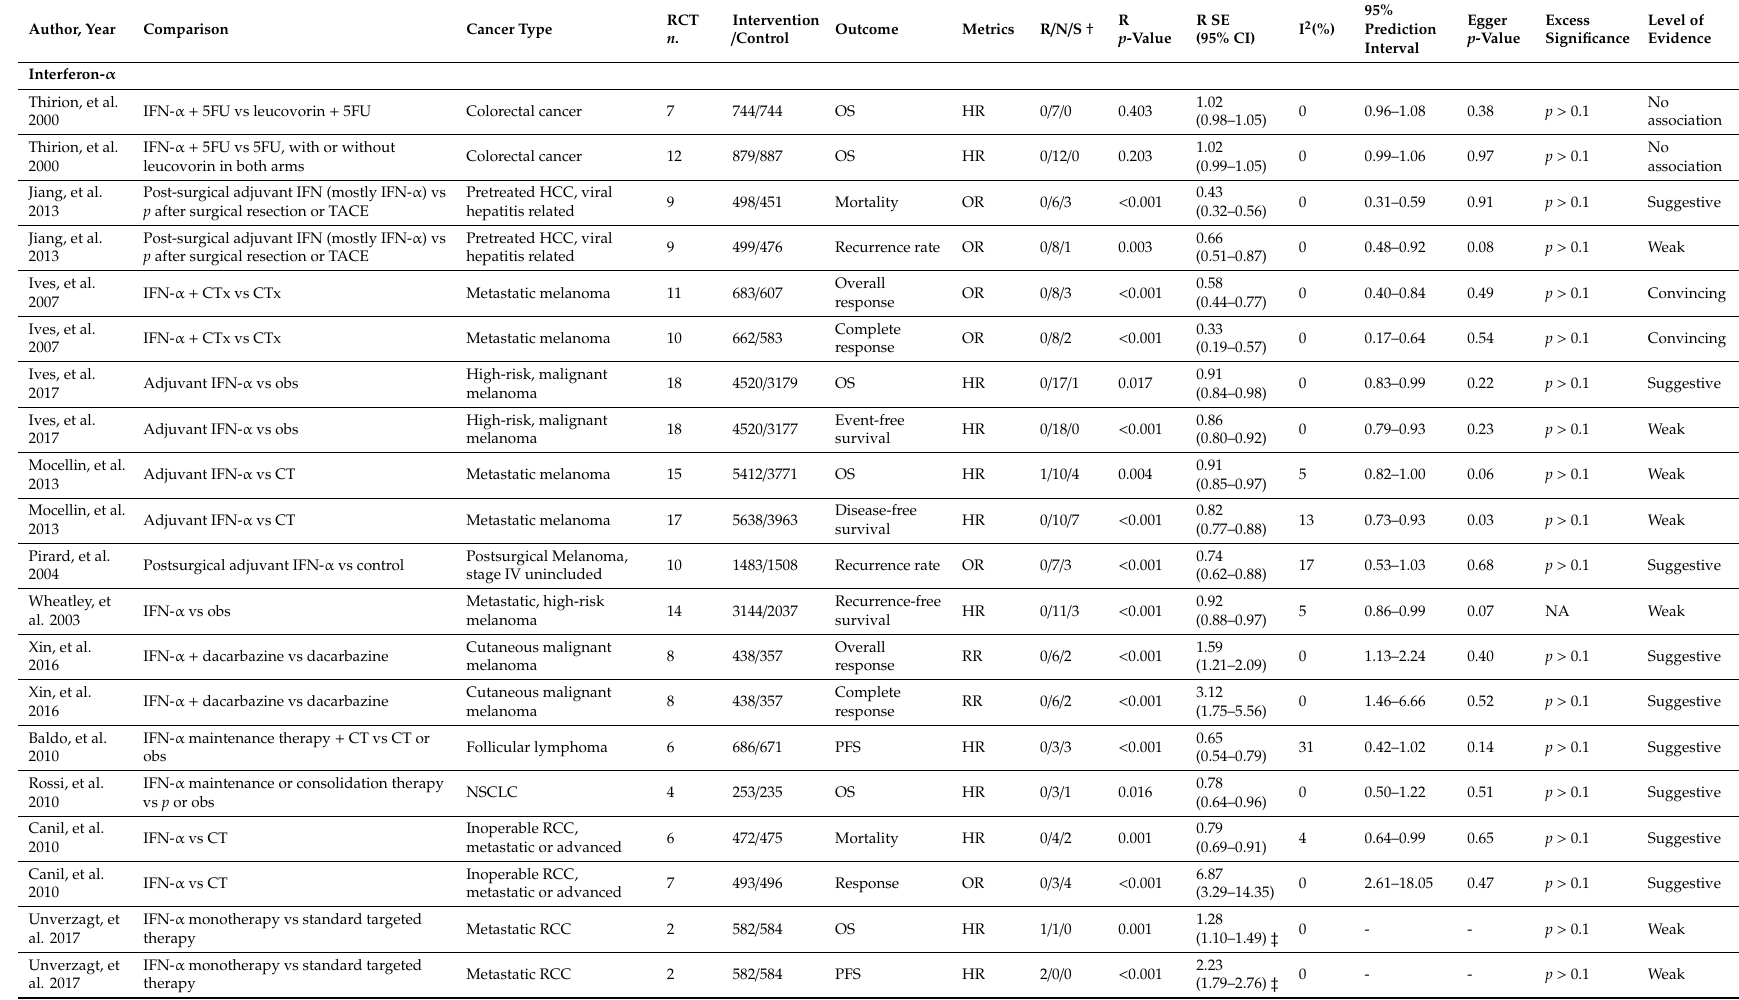
Table 3. Main findings and level of evidence reported in meta-analyses of cancer therapeutic immunomodulatory cytokines and cancer